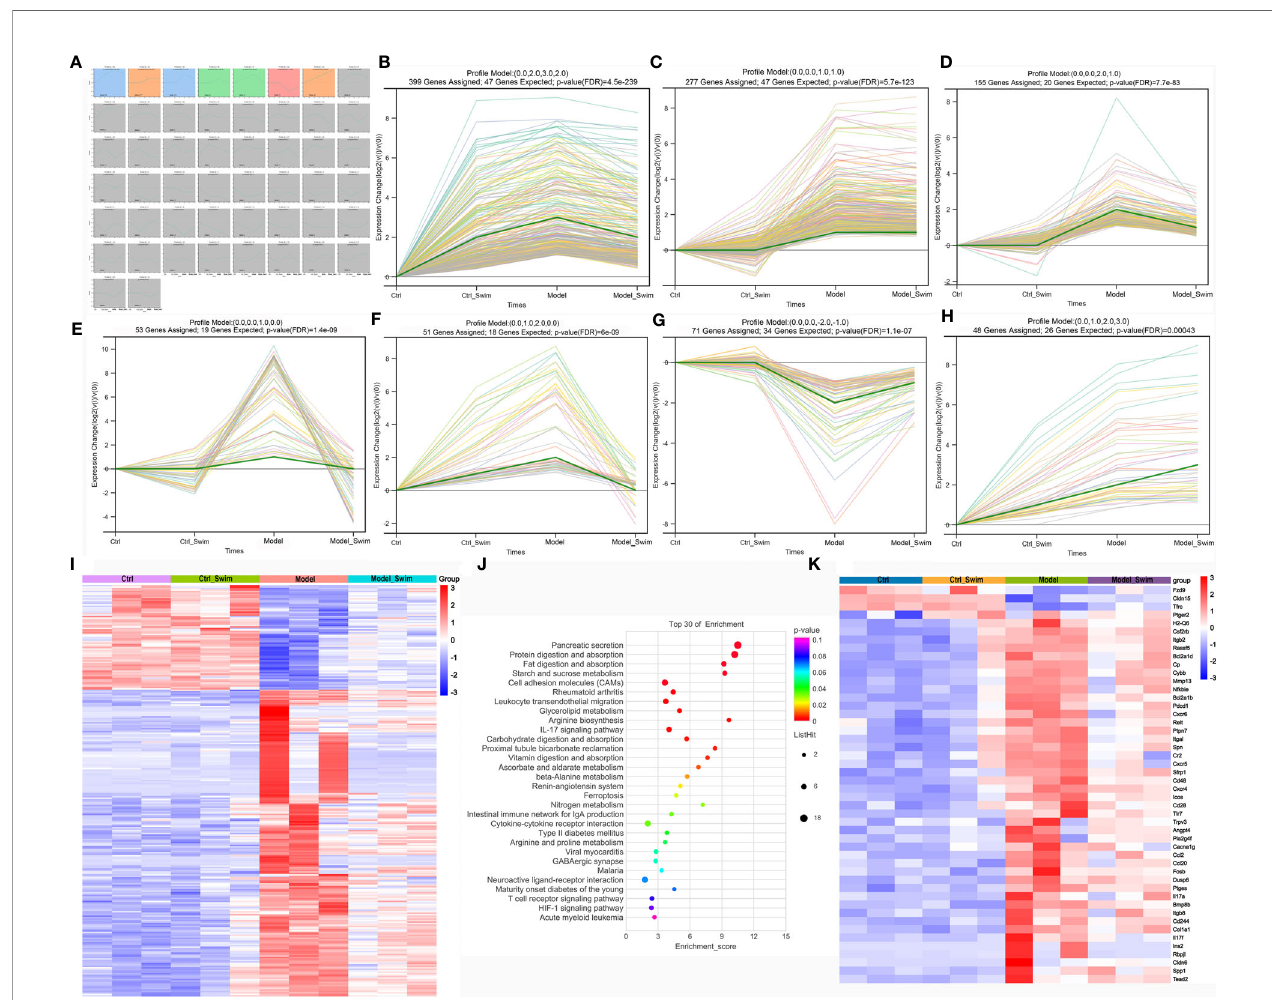
FIGURE 3 | Variations in transcription induced by AOM/DSS and swimming pretreatment. (A – H) Patterns of gene expression across the four groups inferred by Short time − series expression minor clustering analysis (STEM) analysis. (I) Heatmap of the differential genes caused by swimming in AOM/DSS-induced CAC Mice. (J) KEGG enrichment analysis of the differential genes caused by swimming in AOM/DSS-induced CAC Mice. (K) Heatmap of the screened 48 differential genes caused by swimming in AOM/DSS-induced CAC